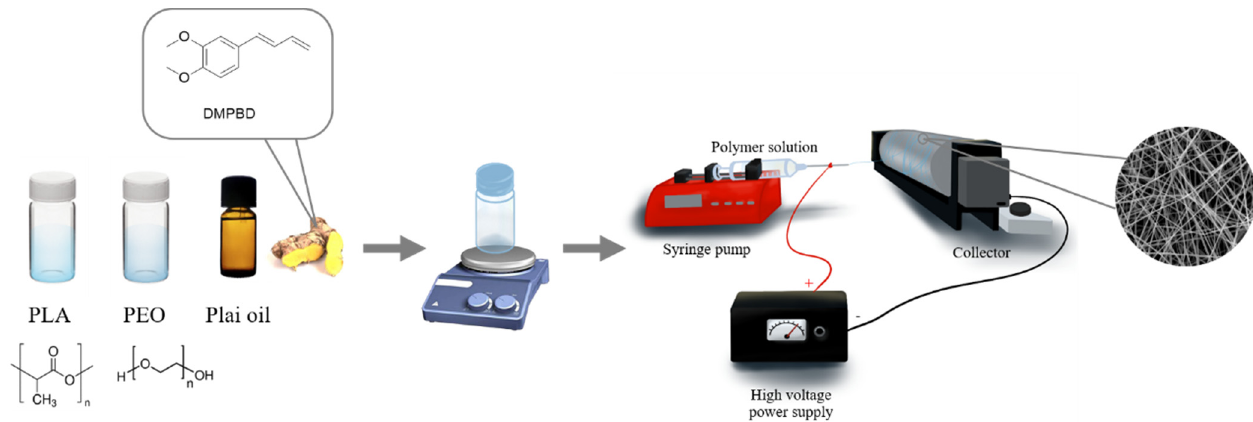
Scheme 1. Schematic representation for the fabrication of the Plai essential oil-loaded electrospun PLA/PEO fibrous mem-